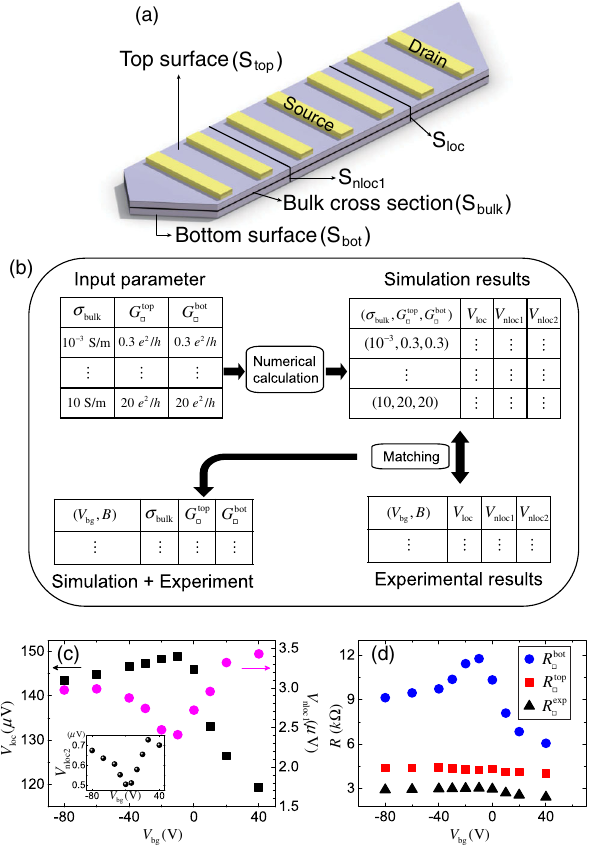
FIG. 3. (a) Simulation model (the thickness of BSTS is ¼ 100 nA is injected from exaggerated for visual clarity). I bias the source to the drain. S ( S ) represents the hypothetical loc nloc 1 plane used to extract the total current through the cross-sectional area between the two voltage probes of V ( V ). (b) Sche- loc nloc 1 matic diagram for methodology of this study, illustrating how to determine an optimal set of values for ( σ , G top □ , G bot □ ) by bulk , V , V ) to the simulated matching an observed set of ( V loc nloc 1 nloc 2 results. (c) V dependence of V (black squares) and V bg loc nloc 1 (magenta circles) taken at 4.2 K. The inset shows V vs V . nloc 2 bg (d) Simulation results of R top □ ð¼ 1 =G top □ Þ and R bot □ ð¼ 1 =G bot □ Þ , V , and V simultaneously matched to the measured V loc nloc 1 nloc 2 Þ is also plotted for compari- W for each value of V . R exp □ ð¼ V loc bg L I bias son, where L is the center-to-center distance of the two voltage and W is the width of our probes of V loc